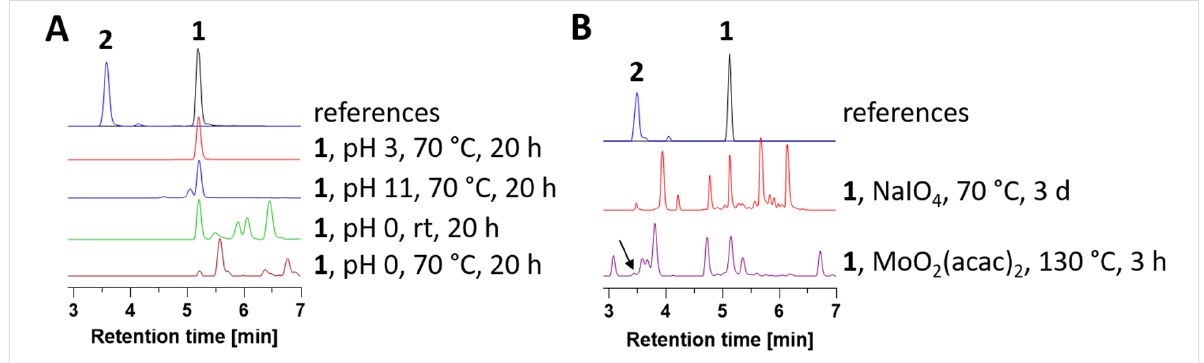
Figure 4: Intrinsic reactivity of 4ß-hydroxywithanolide E ( 1 ) under acidic/basic and oxidative conditions, respectively. (A) LC–MS chromatograms (ELS detection) of 1 incubated at different pH values. (B) LC–MS chromatograms (UV detection at 200–400 nm) of 1 treated with different oxidative reagents. The formation of 2 in the NaIO 4 reaction was confirmed by NMR analysis. See also Figure S21 in Supporting Information File 1 for extracted ion chromatograms (EICs).